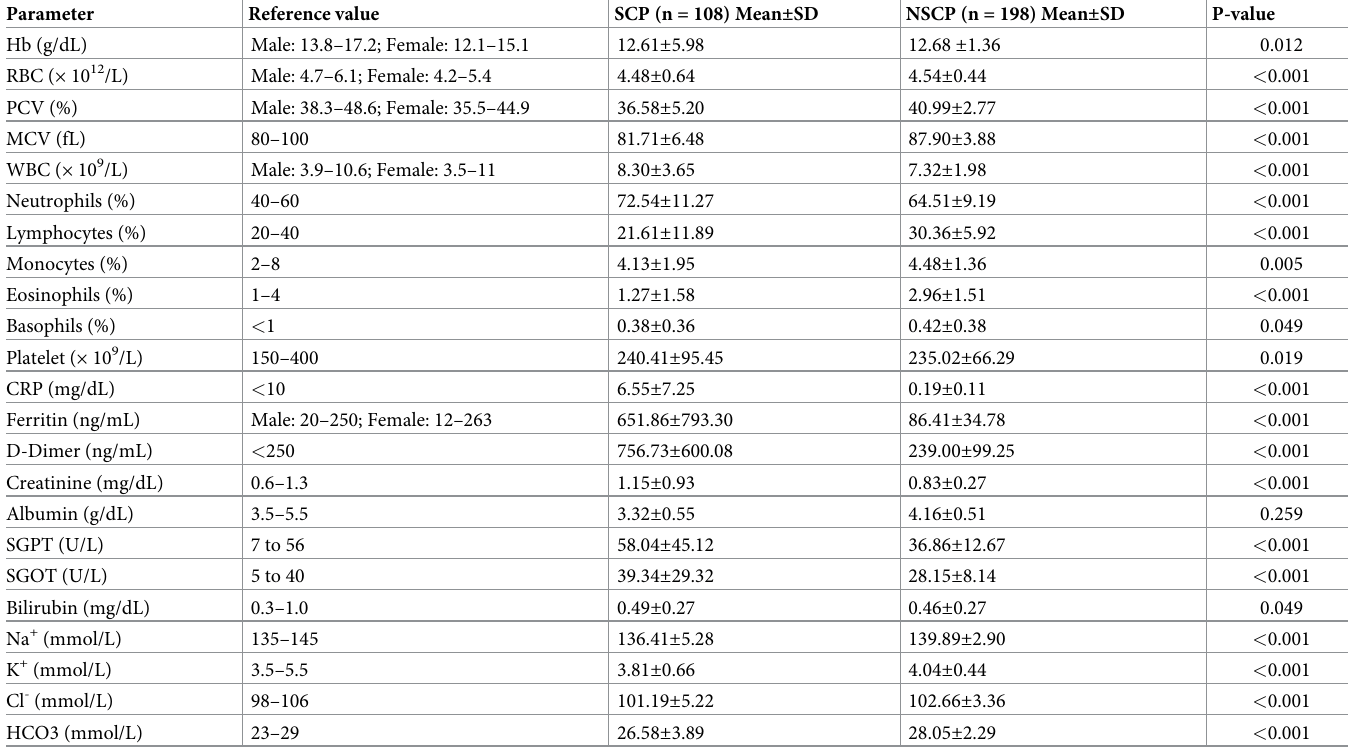
Table 2. Hematological parameters of the study cohort at different severity levels of